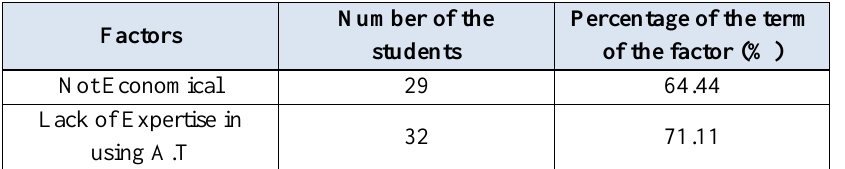
Table 6. Percentage of pre-service students and the factors hindering utilization of helpful technology Number of the Percentage of the term Factors students of the factor (%) Not Economical 64.44 Lack of Expertise